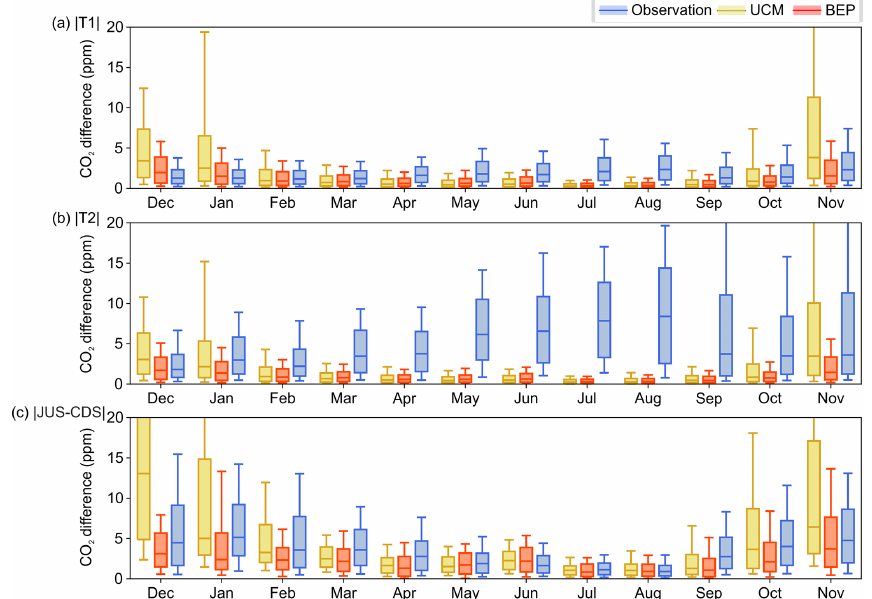
Figure 6. Distribution of the GreenLITE ™ observed and modeled absolute CO 2 concentration differences between all pairs of chords for (a) T1 and (b) T2 from December 2015 to November 2016. (c) Distribution of the observed and modeled absolute CO 2 concentration differ- ences between JUS and CDS from December 2015 to December 2018. The midpoint, the box, and the whiskers represent the 0.5 quantile, 0 . 25 / 0 . 75 quantiles, and 0 . 1 / 0 . 9 quantiles, respectively. Note that only the afternoon data (11:00–16:00UTC) are used in the